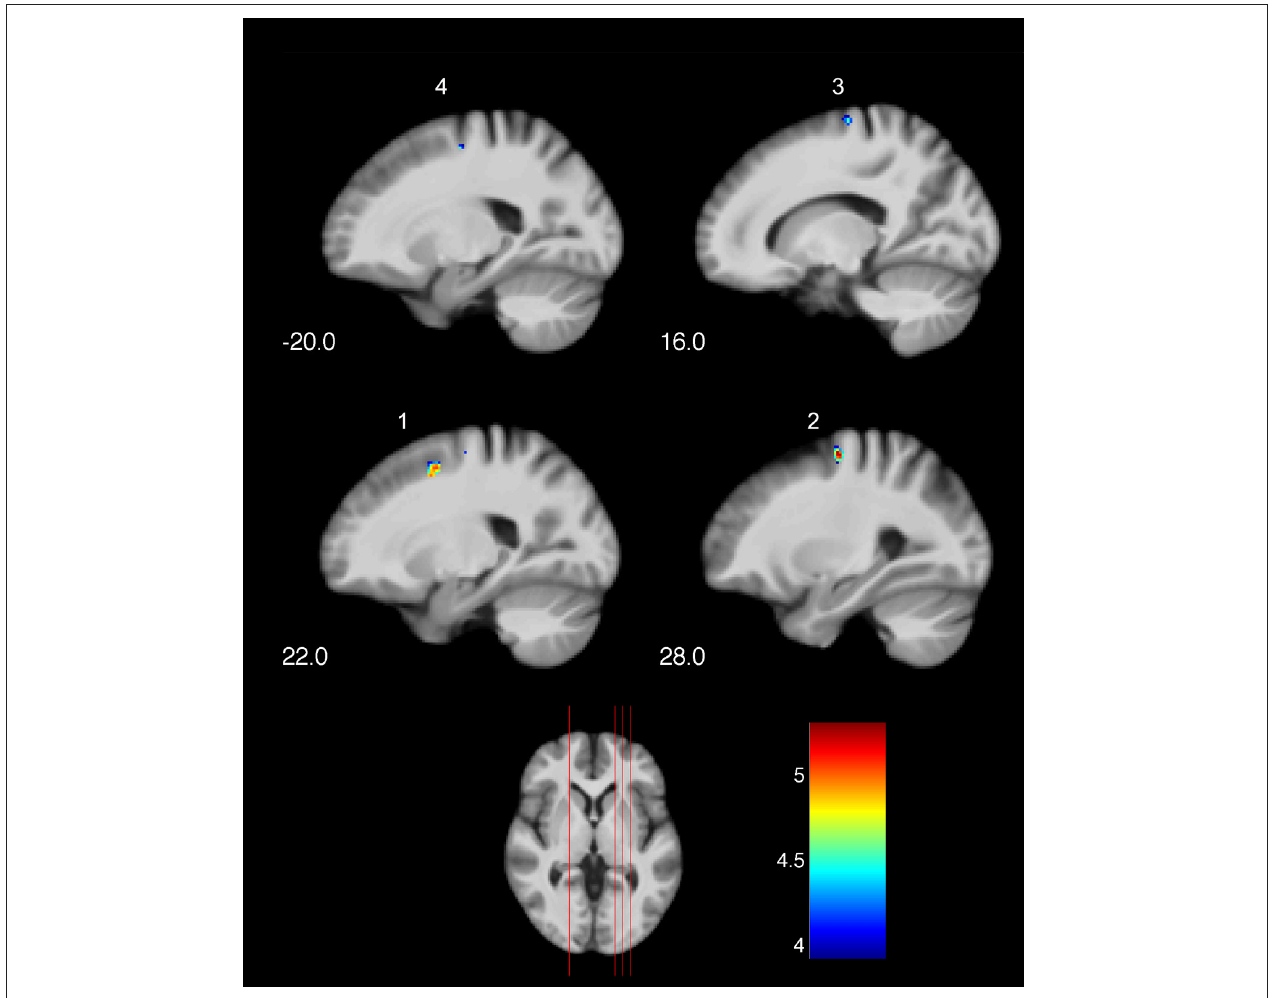
FIGURE 2 | Training-induced changes of neuronal recruitment while mentally rehearsing a golf swing (MI). (1), (2), (3) right premotor cortex; (4) left premotor cortex. The color bar represents the T -values. The indices relate to the numbers used in Table 4 and Figure 3